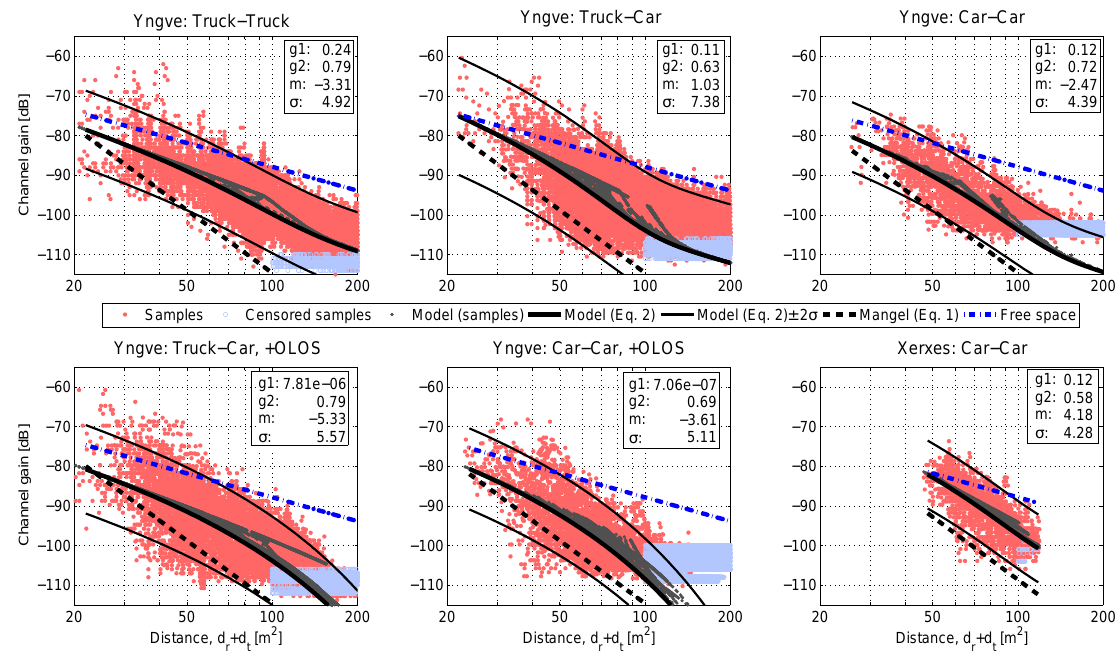
Figure 7. Channel gain vs. the Manhattan-distance ( d t + d r ) for all communication link types in intersection Yngve and the communication link type between the two front cars in intersection Xerxes (see Table 2. The estimated values, in decibels, of the parameters g 1 , g 2 , m , and σ for the model (2) are shown in each subfigure. Both the Mangel-model (1) and the free space model are plotted for reference. The grey curves represent (2), based on the measured samples, and since our proposed model is based both on ( d t + d r ) and ( d t · d r ), we actually have two dimensions of the distance influence. The lines showing the model (1), (2), and free space are based on fictive test scenarios where two vehicles are approaching Yngve or Xerxes and then stop. The fictive test scenarios use the estimated parameter values for each link type. Table 3. Estimated parameters for the proposed path loss model (2) in the two intersections.